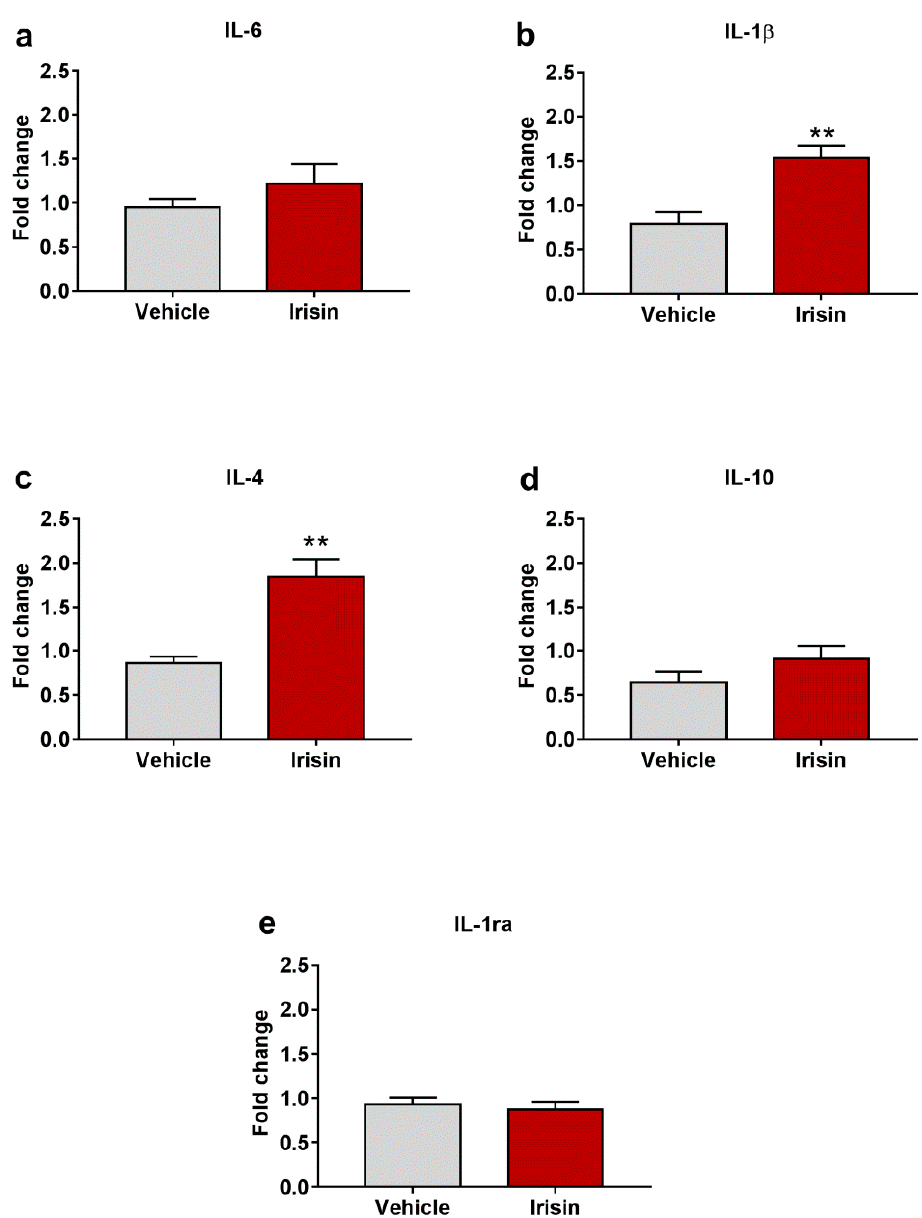
Figure 6. Irisin effect on cytokine profile in brain. Gene expression of Il-6 ( a ), Il-1 β ( b ), Il-4 ( c ), Il-10 ( d ), and Il-1ra ( e ). Histograms represent mean expression ± SEM. Unpaired two-tailed Student’s t -test was used for statistical analysis. ** p < 0.01.